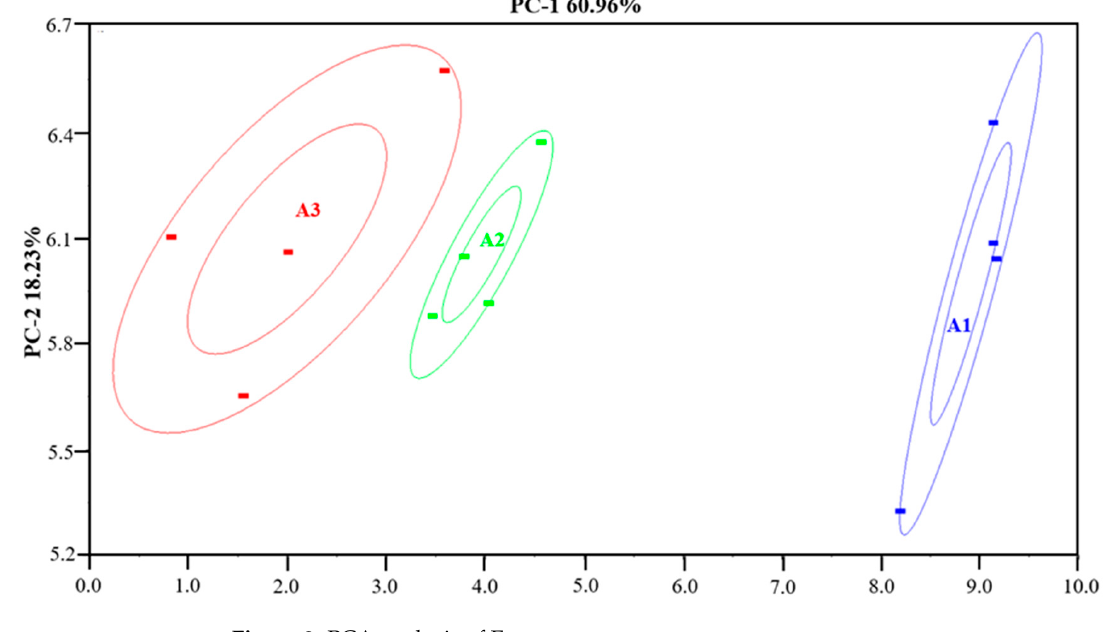
Figure 2. PCA analysis of E-nose.